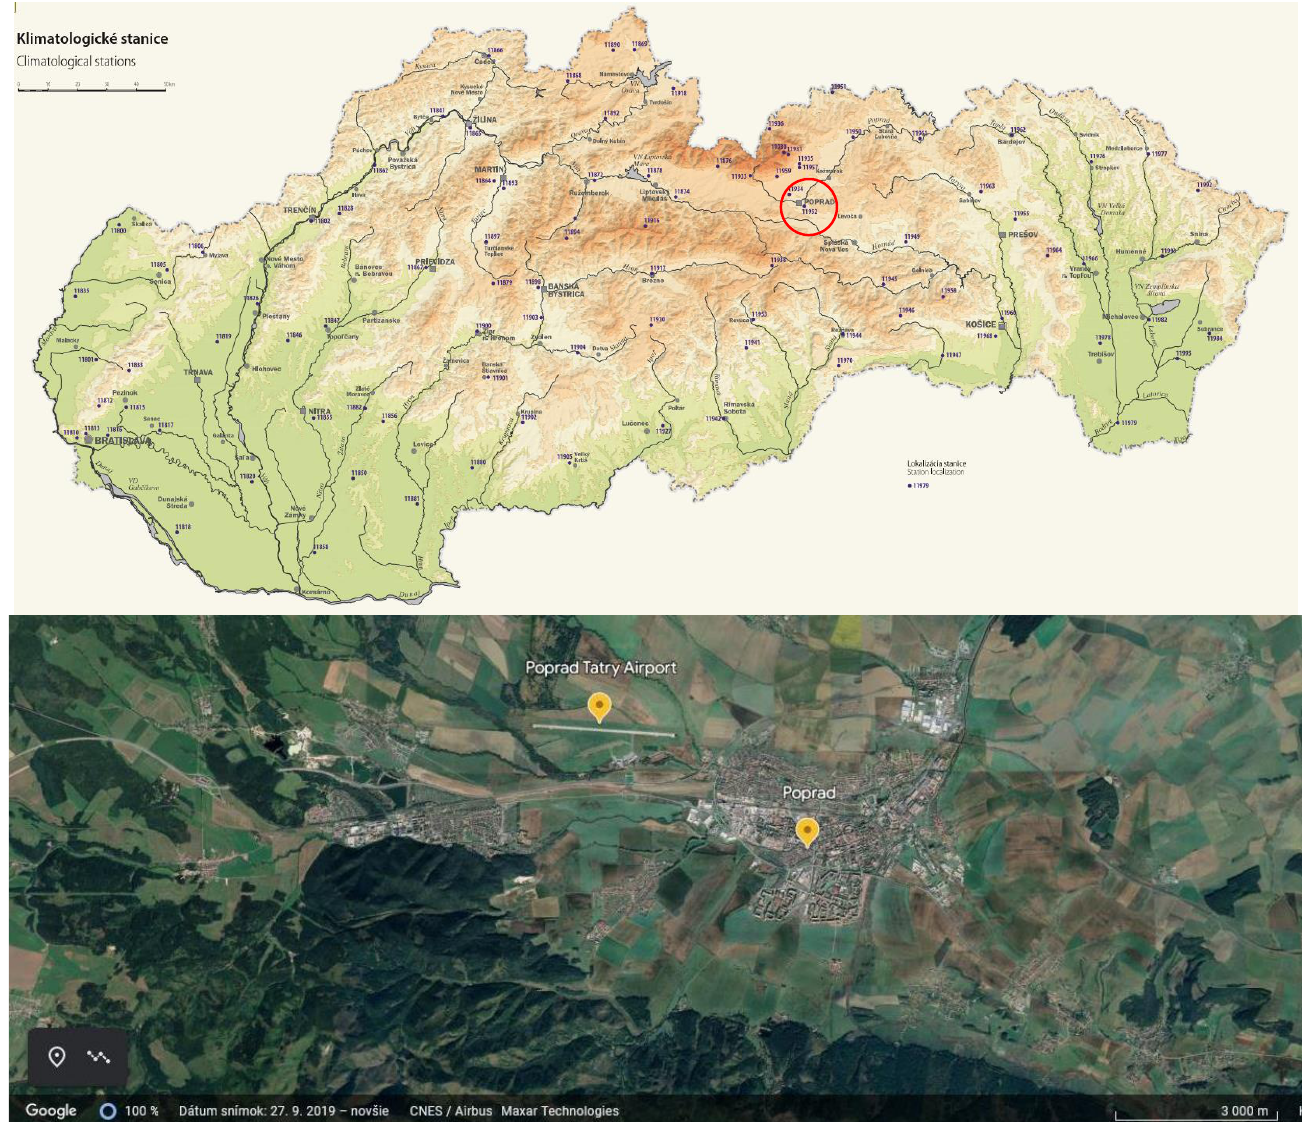
Figure 1. The location of the meteorological station in Slovakia ( upper ); in Poprad ( lower ). Source: [53,54].